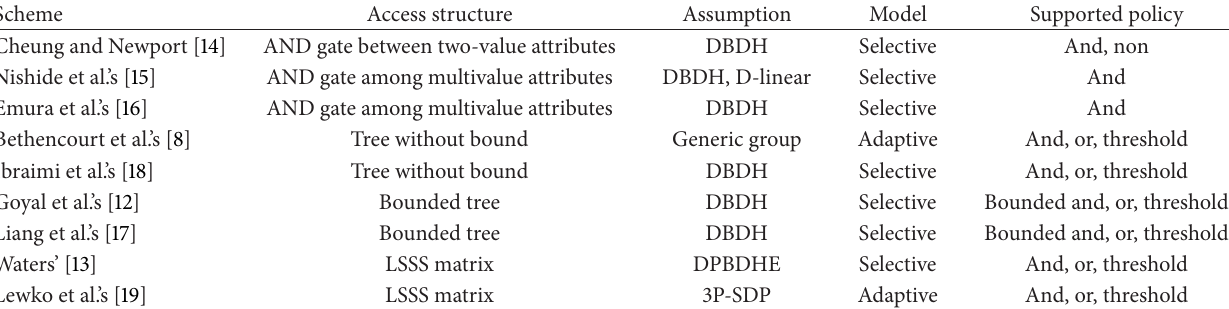
Table 1: Comparison of security proof and policy complexity in different CP-ABE